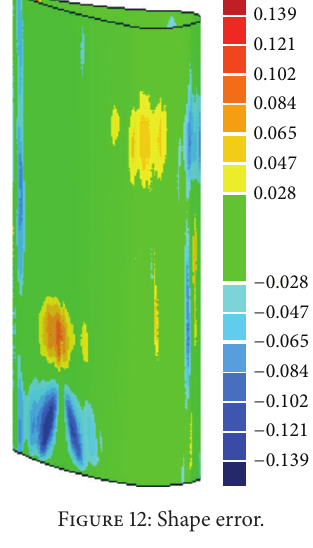
Figure 12: Shape error.